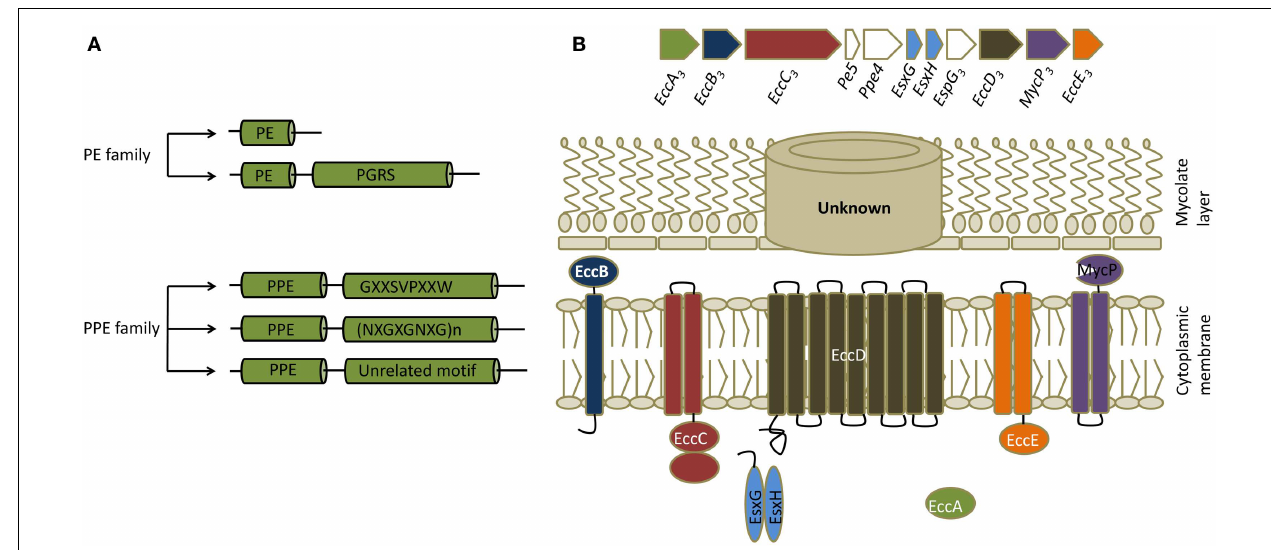
FIGURE 2 | PE/PPE and ESX proteins . (A) Classification of PE/PPE proteins. PE/PPE proteins are broadly divided into PE and PPE proteins based on their characteristic N-terminal proline-glutamic acid (PE) and proline-proline-glutamic acid (PPE) sequences.These motifs occur within a span of ∼ 110 aminoacids in PE proteins and ∼ 180 aminoacids in PPE proteins.The PE family is further subdivided into two groups based on the presence or absence of a C-terminal domain with multiple tandem repeats of Gly-Gly-Ala or Gly-Gly -Asn sequences (PGRS, polymorphic GC-rich repetitive sequences).The PPE family is subdivided into three groups based on characteristic motifs in their C-termini, as indicated. (B) General features of ESX secretion systems. Organization of genes in the ESX-3 cluster, which induced maximal responses in the CD4 + T cell screen, are shown along with a schematic of a typical ESX or typeVII secretion system. All ESX clusters contain a pair of Esx genes, the products of which form 1:1 complexes that are secreted. ESX clusters can exist as either complete